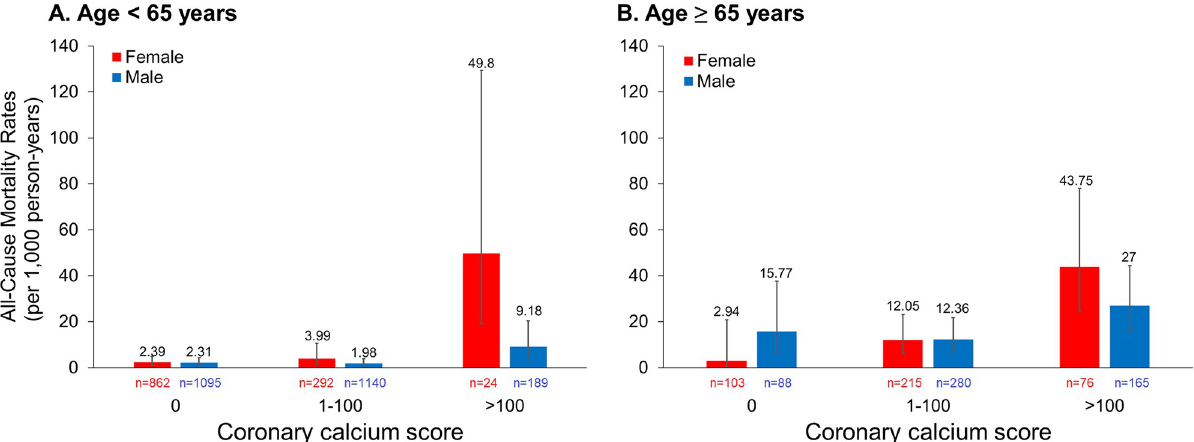
Fig 3. Unadjusted all-cause mortality rates according to coronary artery calcium (CAC) score by age and sex. (A) Age < 65 years and (B) age � 65 years.